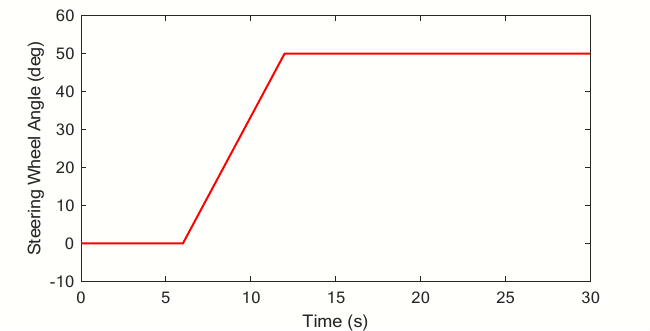
Figure 13. Steering wheel angle at a high-speed small-steering-angle step condition.